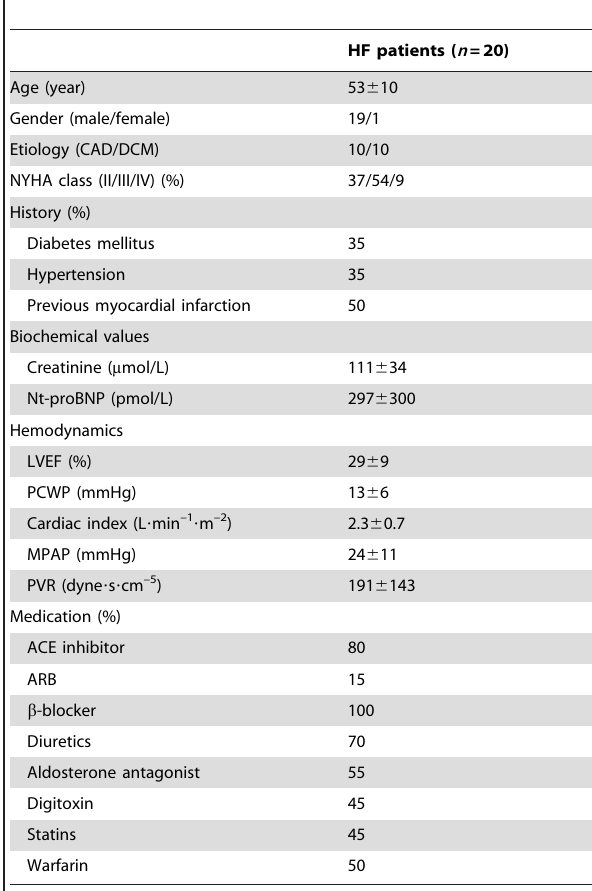
Table 1. Clinical and hemodynamic characteristics of the HF